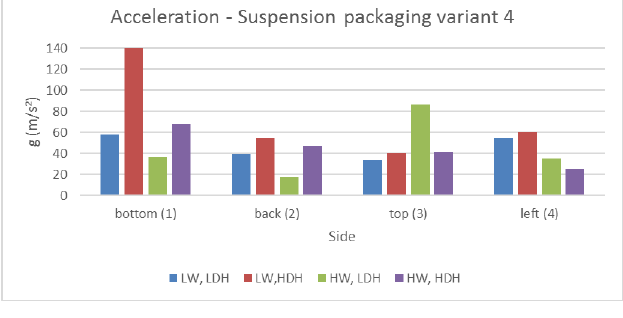
Figure 10: Suspension packaging variant 4